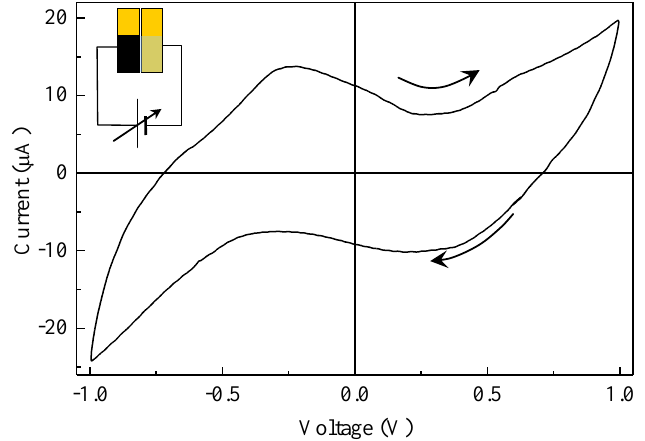
Figure 5. Steady state current-voltage loop of a typical Au/Nafion/MWNTs-Nafion:Cu/Au cell in deionized water. The scan rate is 50 mV/s. The inset shows the polarity of the